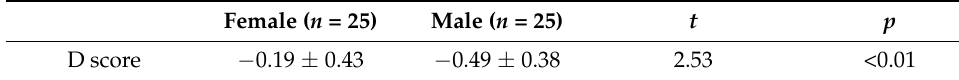
Table 5. Comparison of D scores of implicit attitudes for different